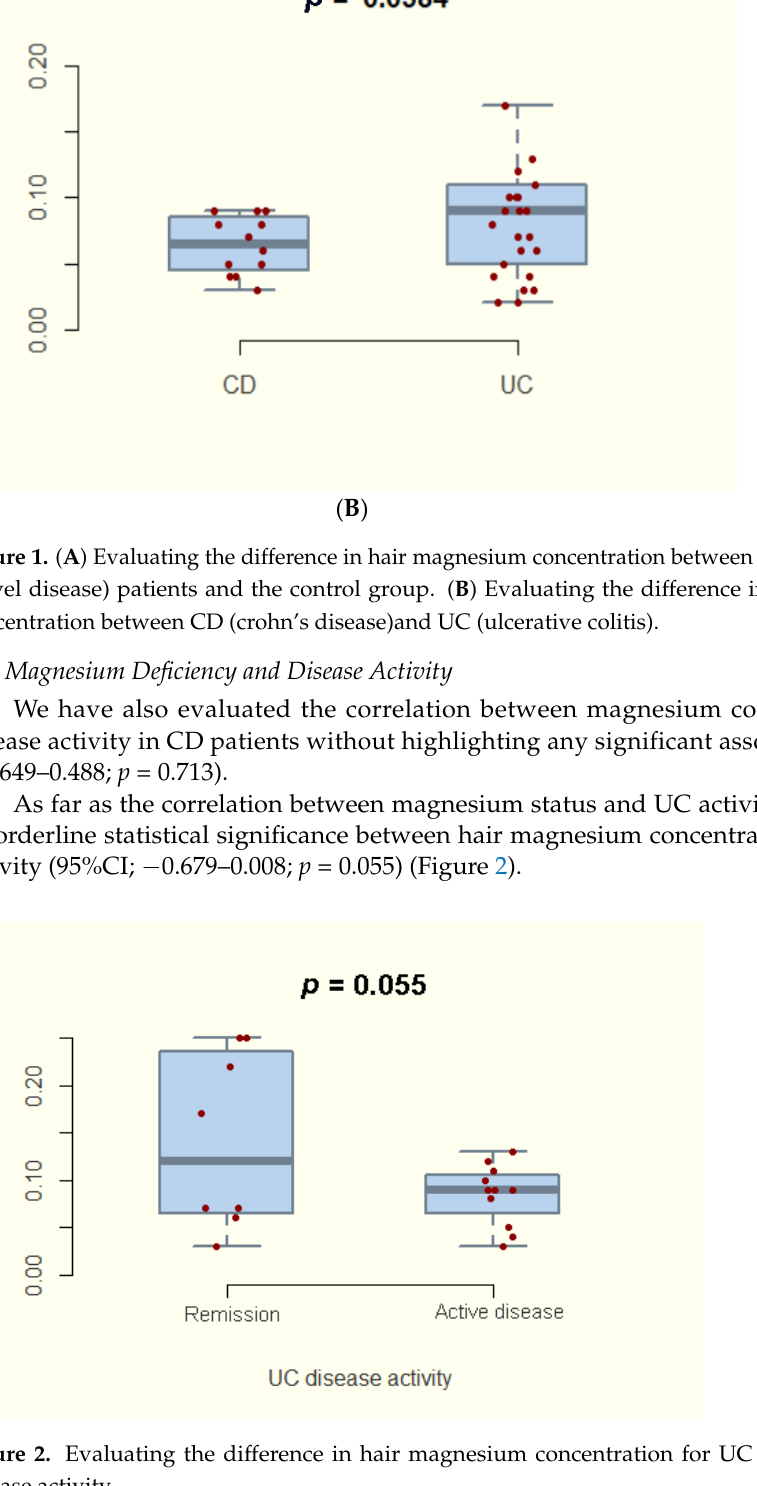
Figure 2. Evaluating the difference in hair magnesium concentration for UC patients based on dis- ease activity .